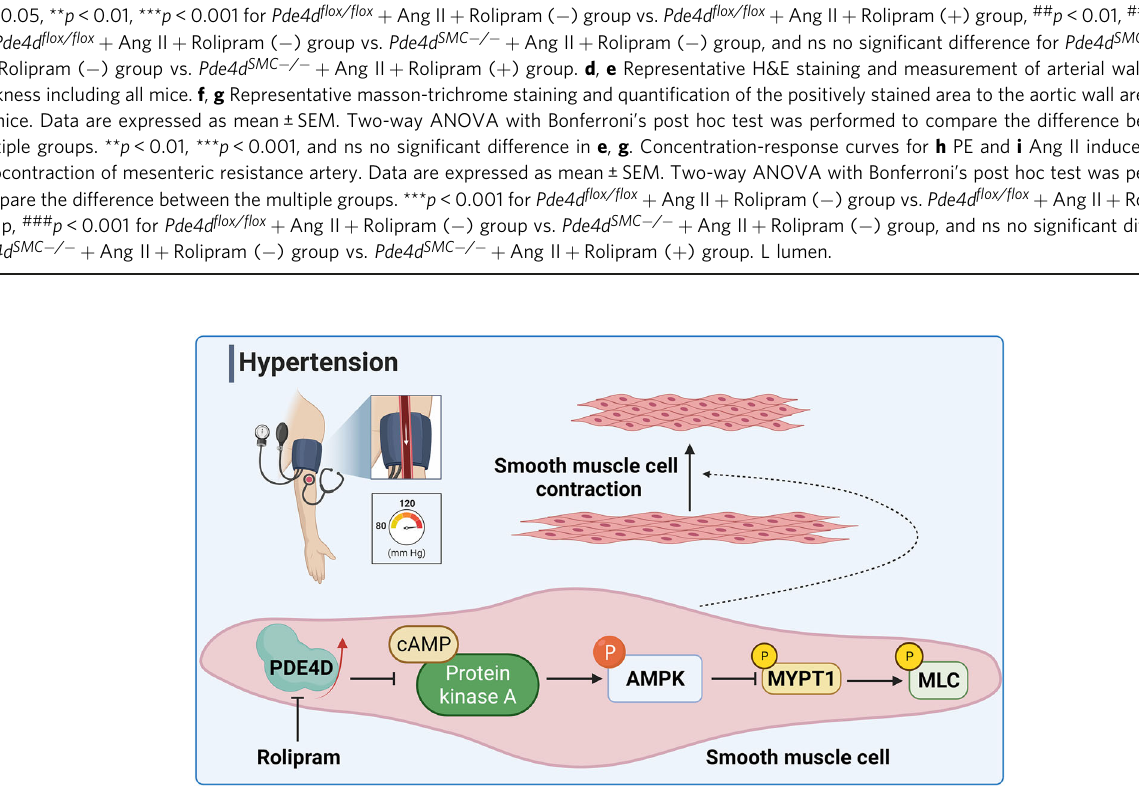
Fig. 7 Rolipram attenuates Ang II-induced hypertension through the inhibition of SMCs PDE4D. a Scheme of Pde4d fl ox/ fl ox and Pde4d SMC − / − mice infused with Ang II and/or treated with rolipram. Rolipram (3 mg kg − 1 day − 1 ) was orally administered daily for 14 days. b SBP and c DBP were measured in Pde4d fl ox/ fl ox and Pde4d SMC − / − mice infused with Ang II and/or rolipram treatment: n = 6 in Pde4d fl ox/ fl ox + Ang II + Rolipram ( − ) group, n = 5 in Pde4d fl ox/